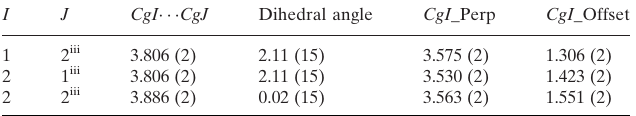
Table 3 (cid:3) – (cid:3) interactions (A˚ , (cid:4) ). Cg 1 and Cg 2 are the centroids of the C9/N10/C11–C14 and C1–C4/C11/C12 rings, respectively. CgI (cid:2)(cid:2)(cid:2) CgJ is the distance between ring centroids. The dihedral angle is that between the planes of the rings I and J. CgI _Perp is the perpendicular distance of CgI from ring J. CgI _Offset is the distance between CgI and perpendicular projection of CgJ on ring I